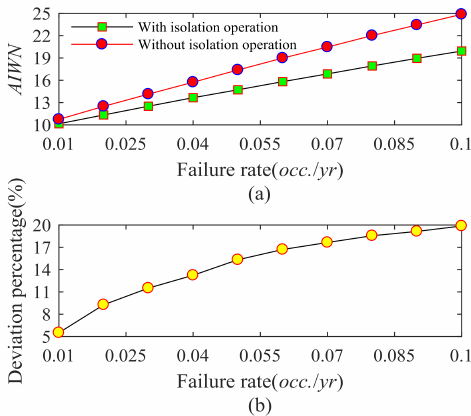
Figure 10. ( a ) AIWN index versus failure rate; ( b ) Deviation percentage of AIWN index between with and without consideration of isolation